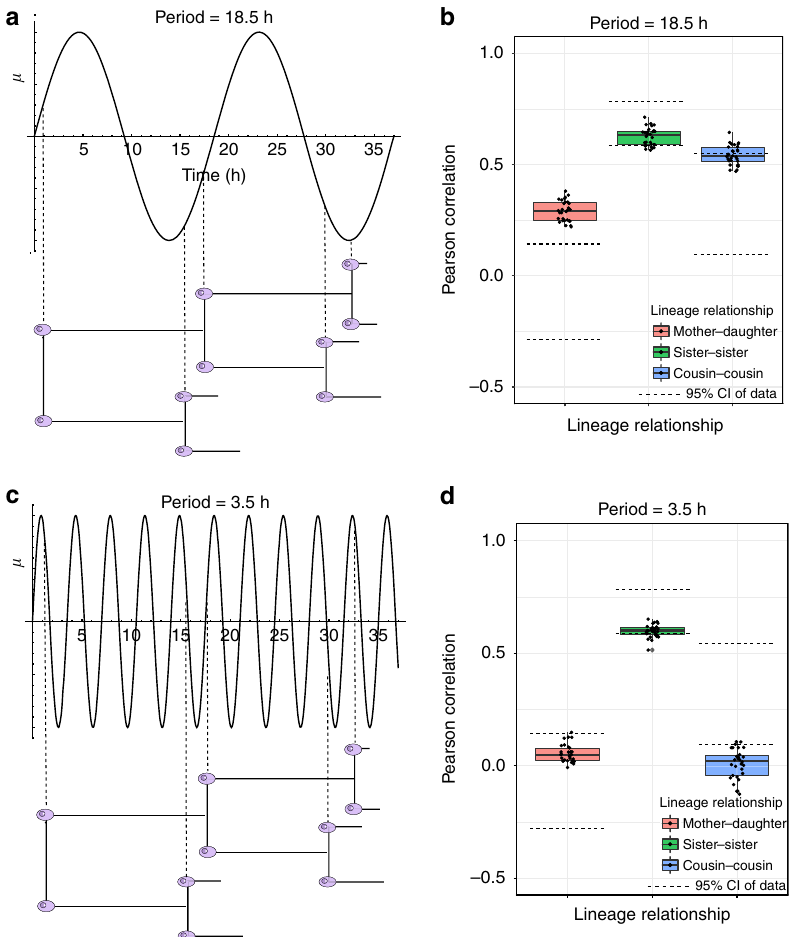
Fig. 6 Most oscillator time periods fail to capture the correlation structure in intermitotic times. a Schematic of an oscillator with an 18.5 h gating of the cell cycle. The inter-mitotic times shown are ~16 h, as observed in the pre-cisplatin HCT116 cells. The standard deviation was chosen as ~2 h to mimic the inferred width of the IMT distribution in Fig. 5b. The dashed vertical lines indicate the phase of the oscillator when a particular cell was born. Similar phases at cell birth result in positively correlated cell division times. This schematic provides an intuitive explanation for the correlation structure obtained from simulations shown in b . b Lineage correlations obtained from simulations when the oscillator has a time period of 18.5 h. The mother – daughter correlations are larger than observed in the data. c Similar to a but for an oscillator with a 3.5 h period. The rapid oscillations and IMT heterogeneity combine to result in random phases at which cousins are born, leading to negligible cousin-correlations as seen in d . d Similar to b but for an oscillator with a 3.5 h period. The cousin correlation is negligible and hence does not recapitulate the experimental data. Parameters used to generate these plots were chosen to generate observed sister correlations (details in Supplementary section 6). All boxplots represent the 1st, 2nd, and 3rd quartiles of the lineage correlations generated from 30 simulation